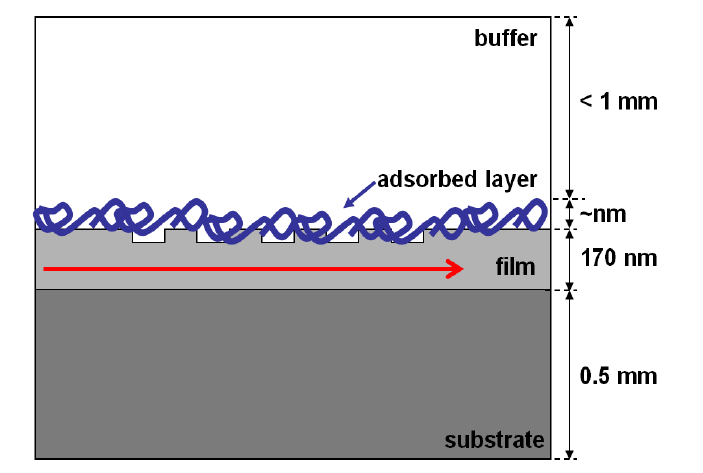
Figure 1. Grating coupler scheme. The molecules attached to the surface form the adsorbed layer. This new layer changes the in-coupling conditions, allowing the